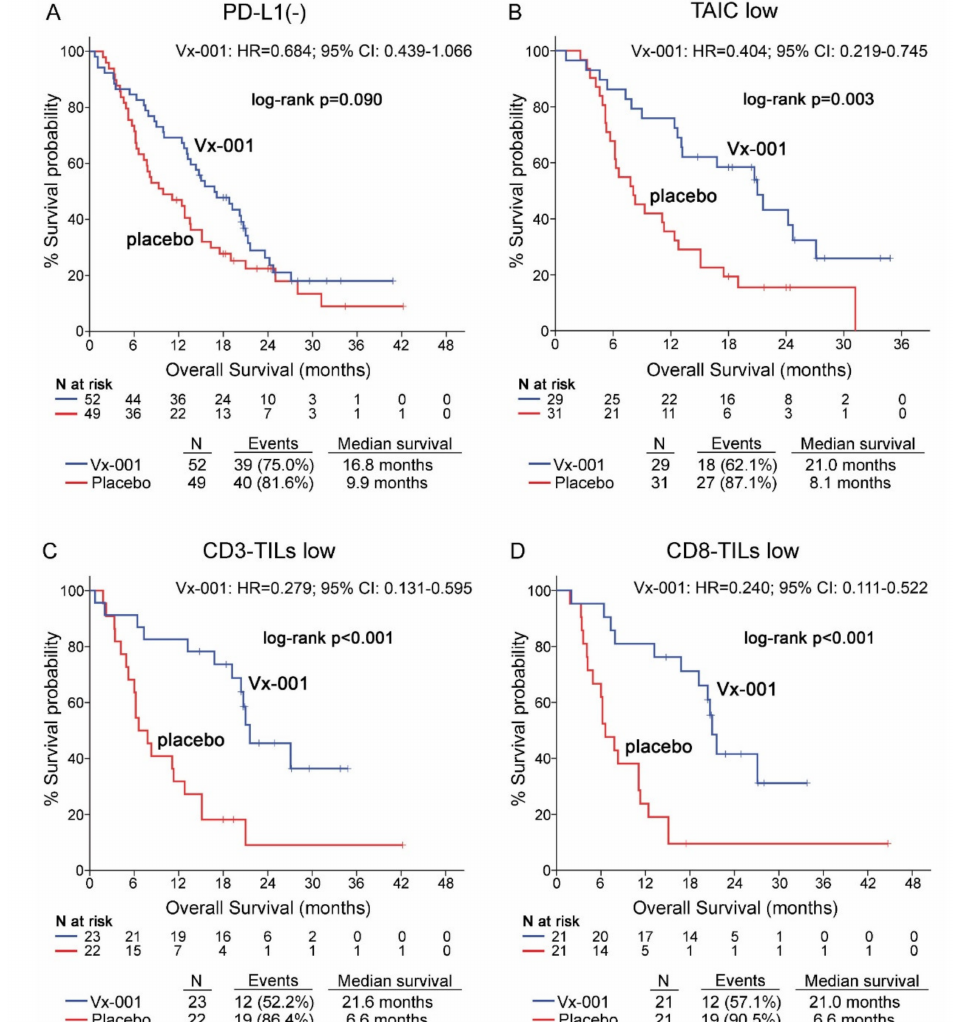
Figure 2. Overall survival (OS) in patients with PD-L1(-), tumor-associated immune cell (TAIC) low, CD3-TIL low and CD8-TIL low tumors. OS was measured in patients with PD-L1(-) ( A ), TAIC low ( B ), CD3-TIL low ( C ) and CD8-TIL low ( D ) tumors. In contrast, Vx-001 did not prolong OS for the patients with TAIC high, CD3-TIL high and CD8-TIL high tumors (Table